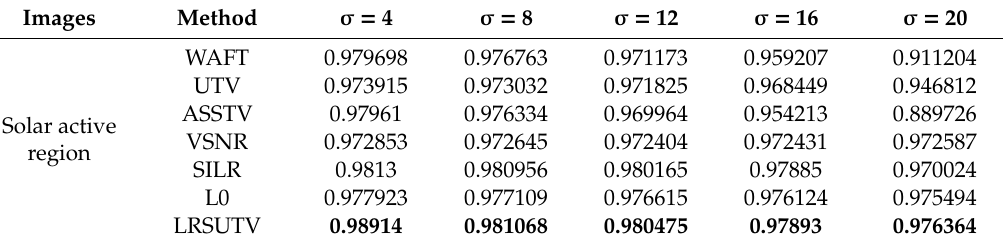
Solar photospheric layer